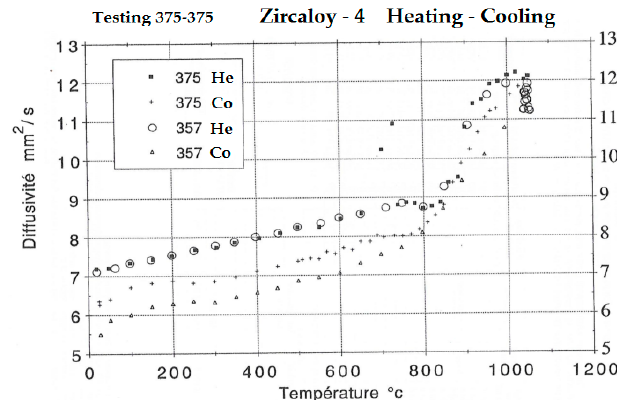
Figure 9. Variation of thermal diffusivity with grain size of samples without corrosion layers.